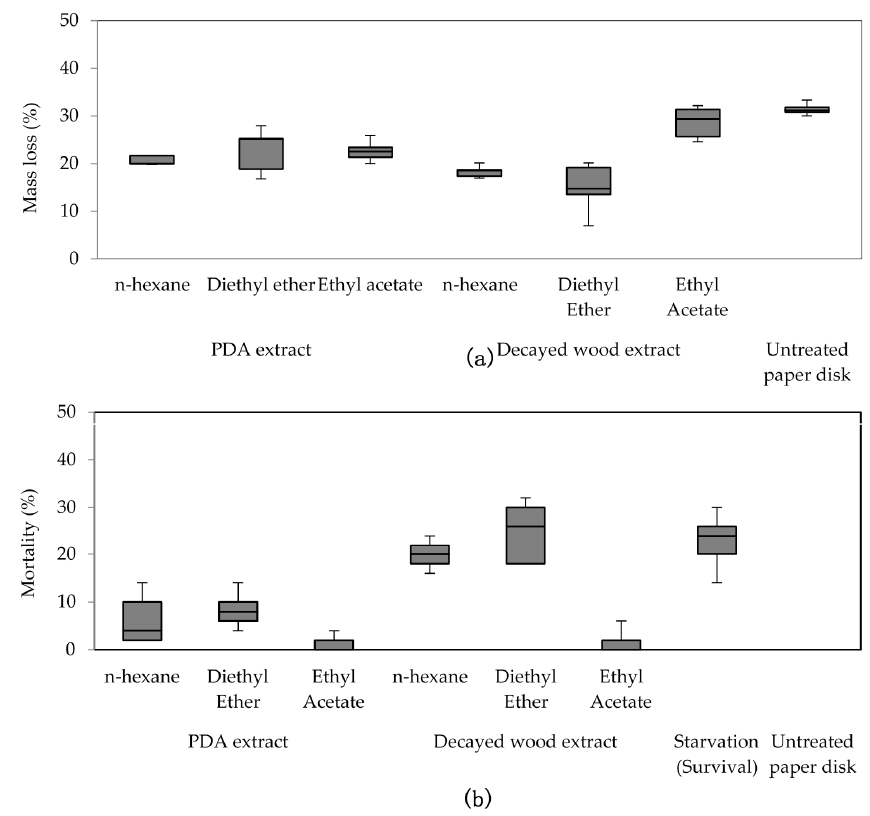
Figure 2. ( a ) Mass loss and ( b ) mortality caused by feeding of purified decayed wood and potato dextrose agar (PDA) extract in a no-choice feeding test (Kruskal-Wallis H test, p < 0.05).